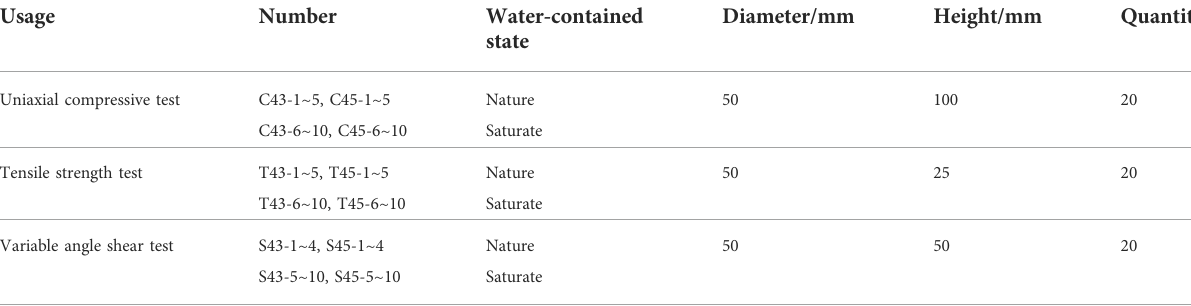
TABLE 1 Specimen use and size.